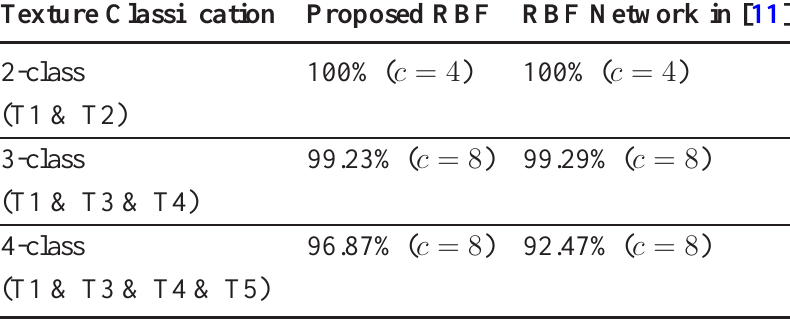
Table 5. The highest CSR of the RBF networks for 2-, 3- and 4-class texture training.